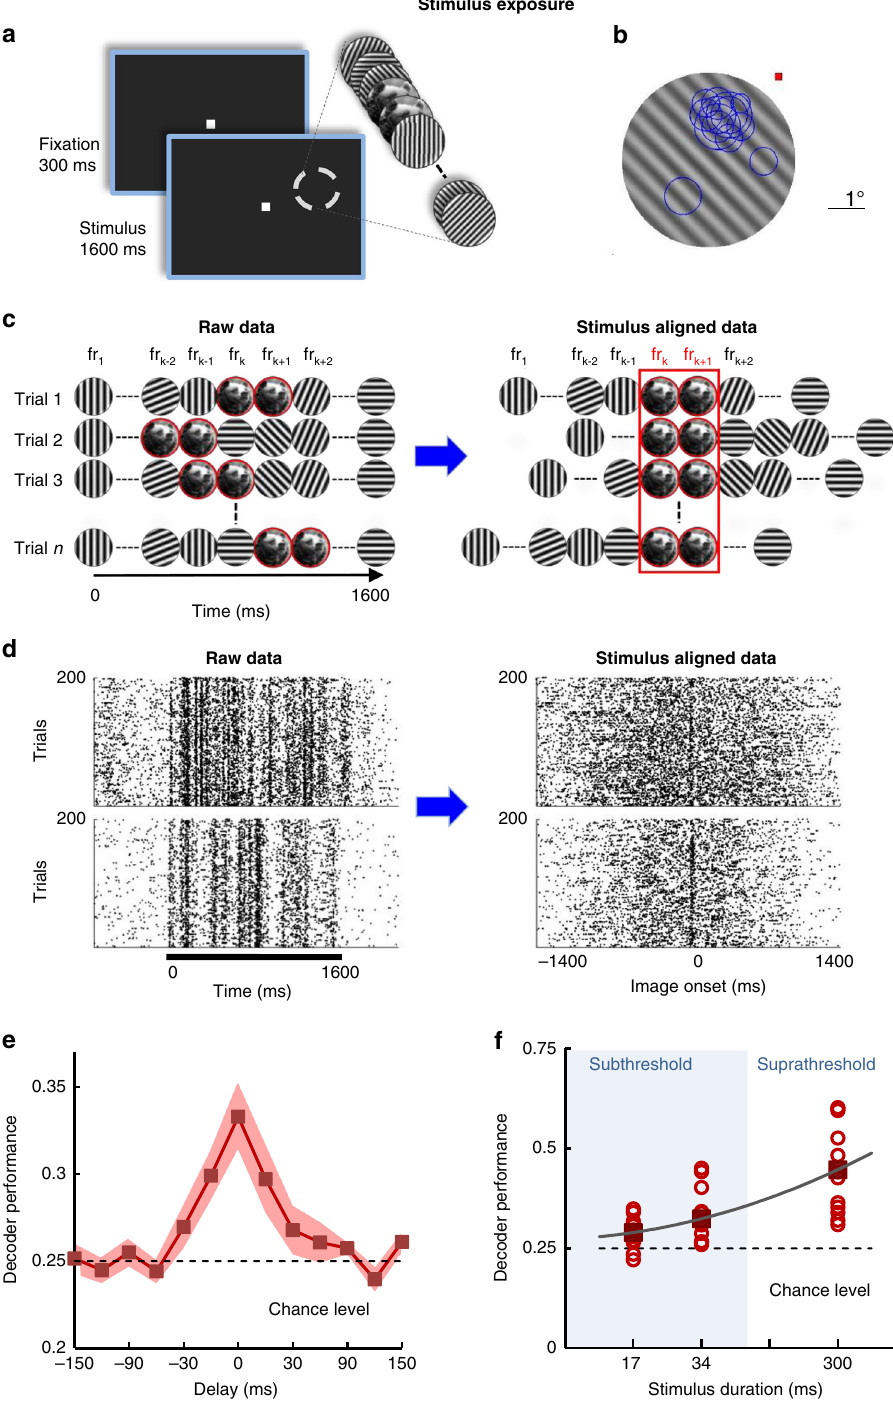
Fig. 2 Neural populations extract stimulus information during exposure. a Exposure – monkeys are performing a passive fi xation task while a natural image is fl ashed for two consecutive frames and is embedded at a random time between frames 10 – 86 into the movie (200 consecutive trials; the image is presented at a range of orientations, as in Fig. 3). b Receptive fi eld positions (blue circles) of individual V1 neurons recorded simultaneously in a representative session shown with reference to a grating frame from the movie stimulus. c Cartoon describing the alignment procedure for analyzing the spike trains during exposure. Spike trains were shifted and aligned with respect to the fi rst frame containing the image (occurring at a random time in each trial; fr k represents the k th frame in the movie). d Raw raster plots for example neurons recorded during stimulus exposure (left). The black bar marks the movie presentation. Same raster plots after alignment relative to the onset of the fi rst image (right). e Decoder performance of a linear classi fi er (using fi ring rates calculated for a 34 ms interval) starting at different delays with respect to image onset. Neurons are reliably encoding image orientation information relative to chance level (shuf fl ed trials) and to epochs in which the two-frame intervals contained random gratings (delays >30 ms). Error represents s.e.m, n = 12 sessions. f Decoder performance for images fl ashed for 17 and 34 ms, and 300 ms is signi fi cantly higher than chance level ( P = 0.0093, P = 0.0048, P = 0.00049, respectively; Wilcoxon sign-rank test). Circles represent individual sessions ( n =